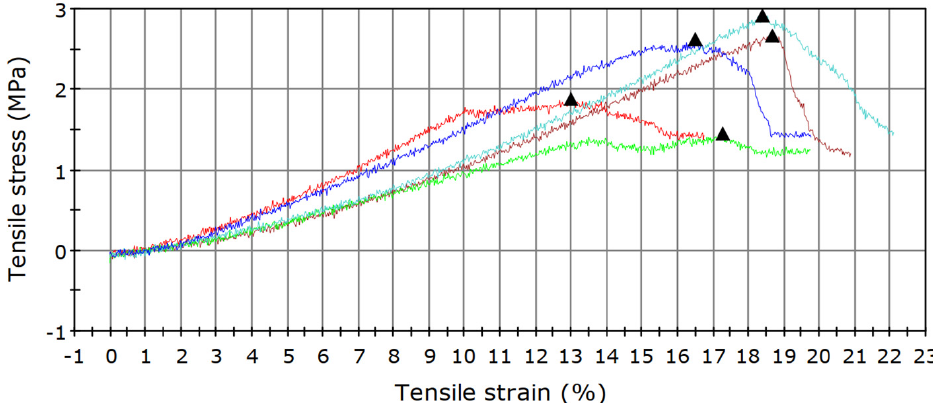
Figure 4. Tensile stress plotted by tensile strain of purified BC.